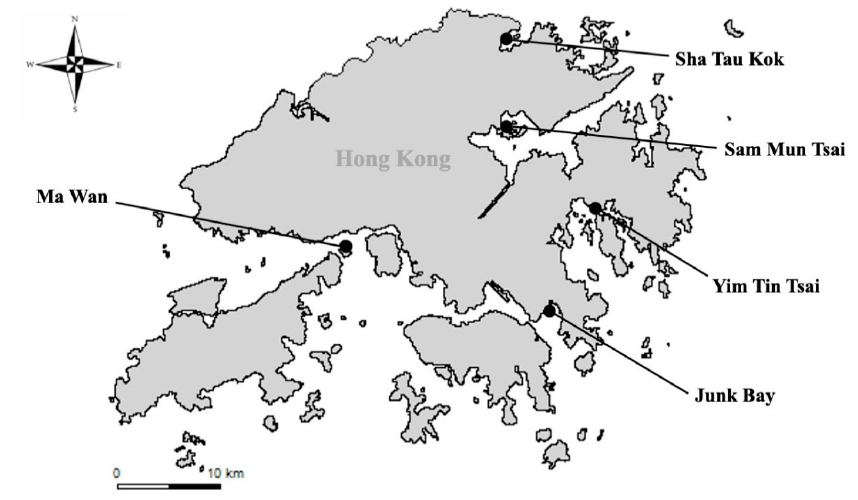
Figure 1. Isolation sites of various dinoflagellate strains used in this study. Table 1. The dinoflagellate strains used in this